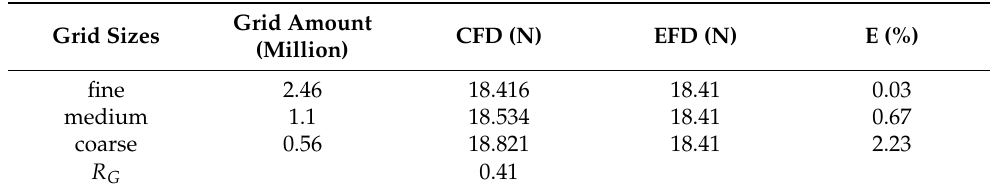
Table 3. Convergence analysis with different mesh sizes.